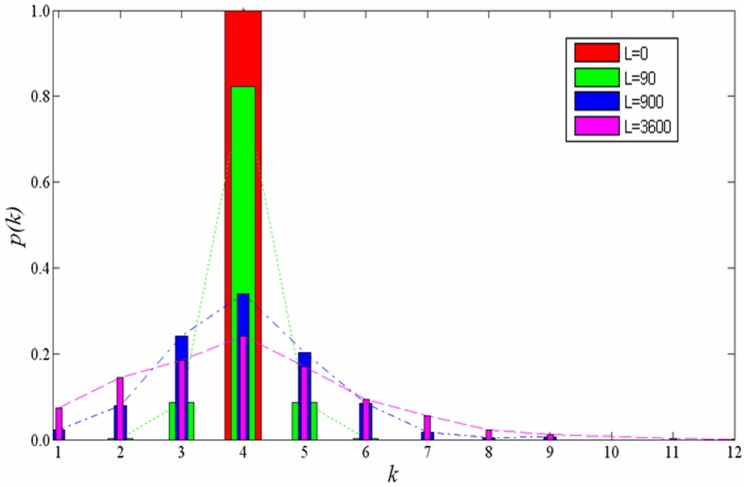
The degree distributions progressively changing from a two-dimensional network to a random graph.The size of the network is 900. The number of rewiring times L is 0, 90, 900 and 3600 respectively. L = 0 corresponds to a two-dimensional lattice. The degree distribution of the network is a δ distribution and the degree of all nodes is four. The node degree of the network progressively changes to a Poisson distribution with the increment of L. The average degree of the nodes remains at four during this process.